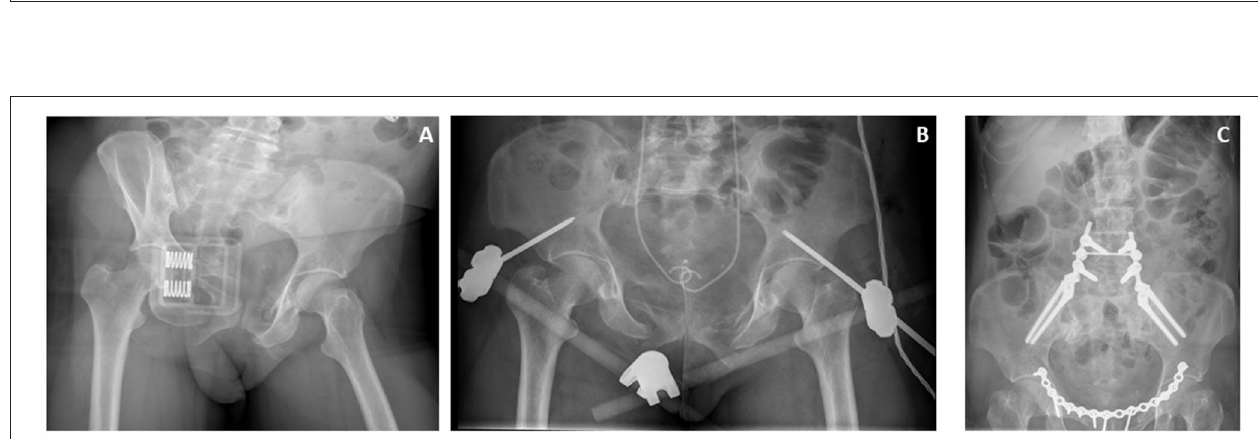
FIGURE 2 | Case of a patient with a hemodynamically unstable pelvic fracture. (A) closure of the pelvic space using a pelvic binder. (B) Supra-acetabular external fixator, and JJ stents after first surgical intervention. (C) Definitive repair including pelvic ring plating, and lumbosacral fixation.